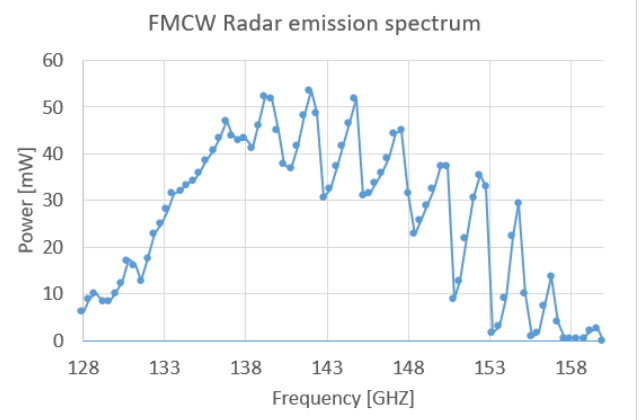
Figure 3. Emission power spectrum of the FMCW radar. The measurement points are the dots. The dots are interpolated by a curve for a better